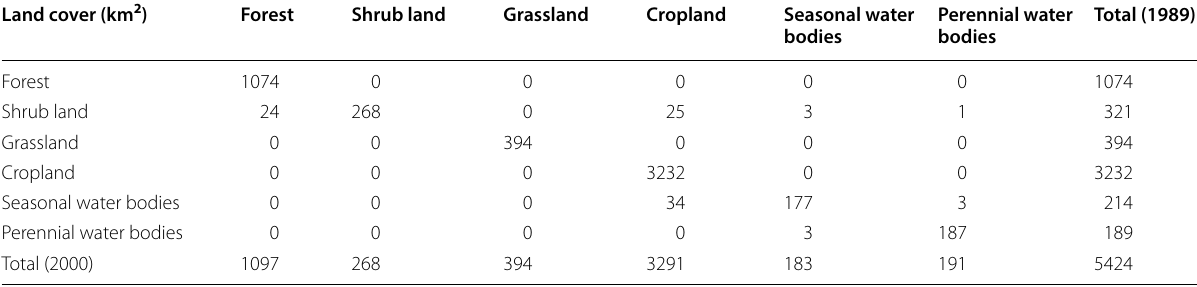
Table 3 2 Change matrix of land cover (km 2 ) in 1989 to 2000 Land cover (km 2